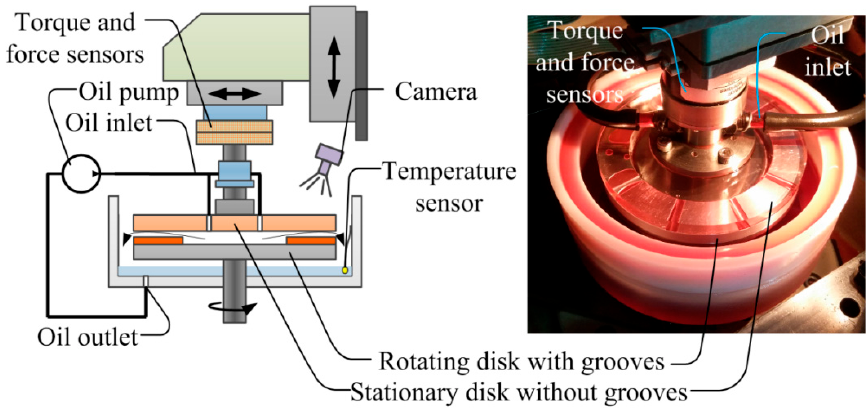
Figure 2. Test apparatus of the grooved rotating-disk system. Table 2. Specifications of the grooved rotating-disk system model.